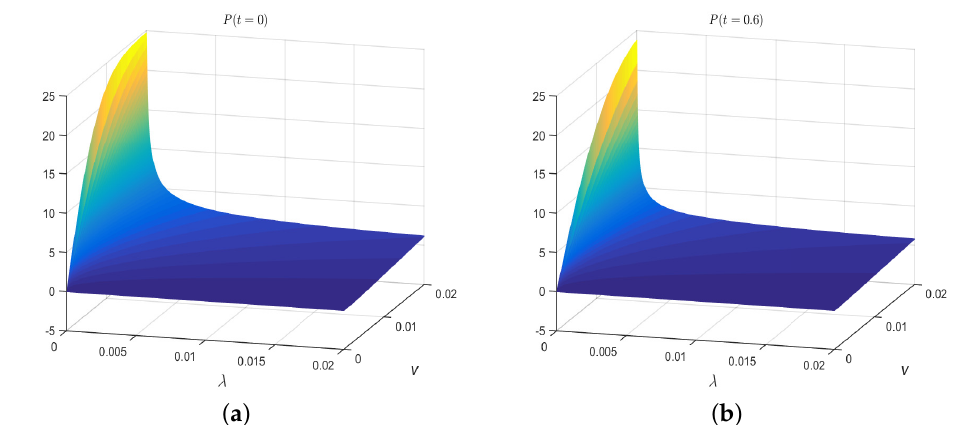
Figure 5. Time evolution of European put option price P ( t ) and dependent on v and λ for t = 0 ( a ) and t = 0.6 ( b ).